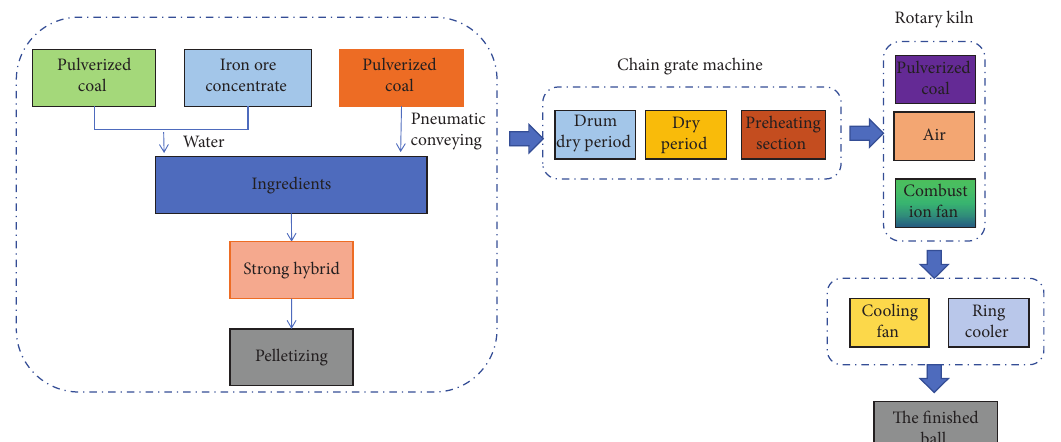
Figure 2: Pellet production process